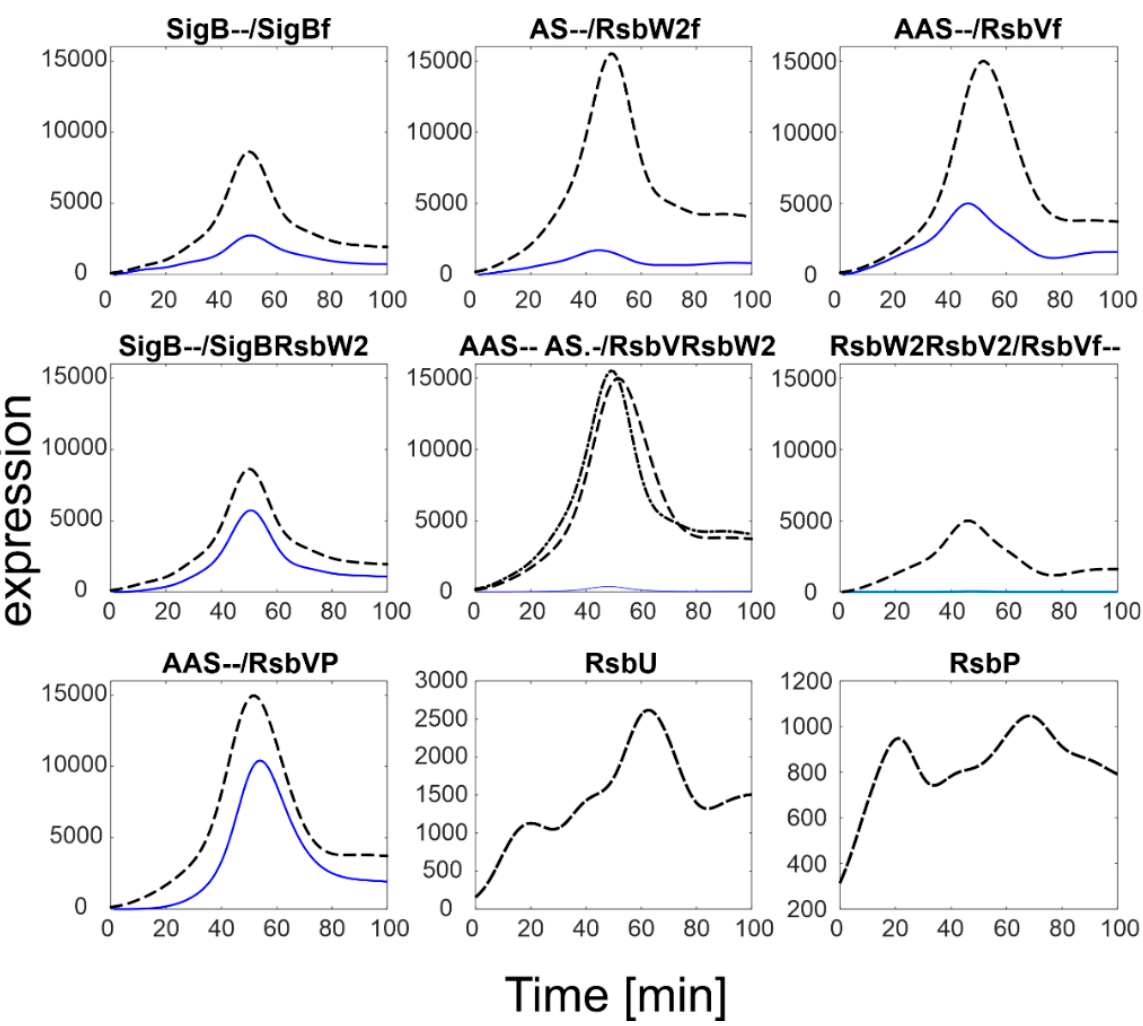
Figure 3. SigB regulatory network simulation results using default parameters from Table 1. Black dashed lines represent smoothed expression profiles of the total amount of the given molecule as measured experimentally, blue solid lines the modeling results. S-measured total amount of SigB, AS-measured total amount of RsbW, AAS-measured total amount of RsbV, index f-free form of the factor. Note a different scale for RsbU and RsbP that is two orders of magnitude lower than that of the SigB operon. Note the scales of RsbU/P are much lower than that of the others.